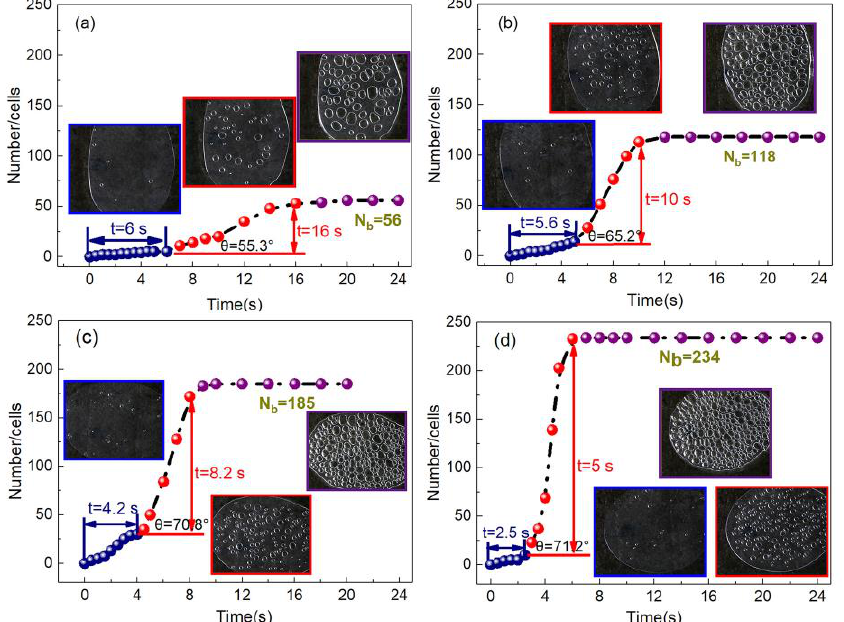
Figure 4. The n - t curves under different temperatures: ( a ) 200 °C, ( b ) 210 °C, ( c ) 220 °C, ( d ) 230 °C.